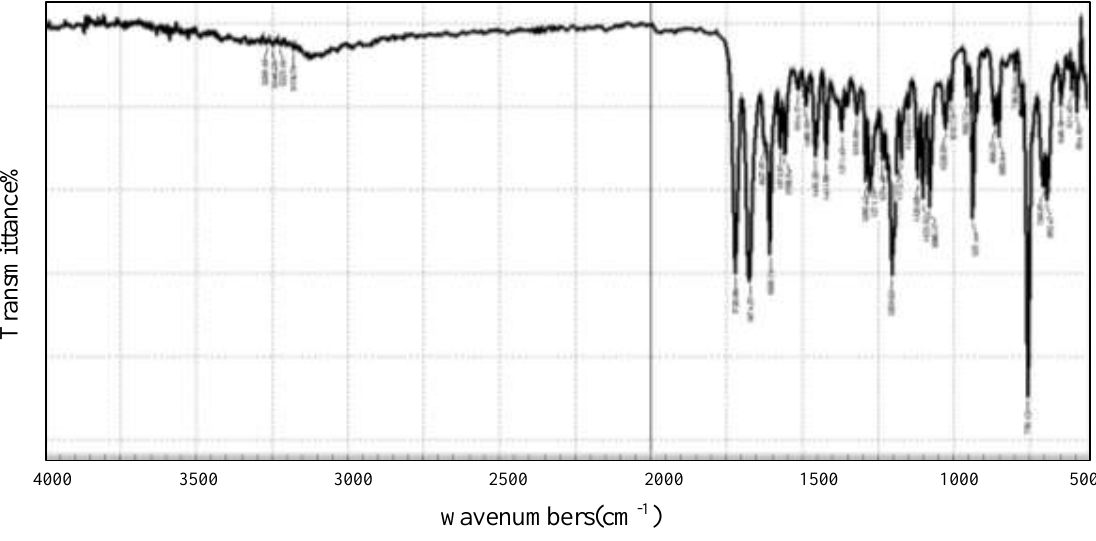
wavenumbers(cm -1 Figure 1: Fourier Transform Infrared Spectroscopy (FT-IR) of ABCP.